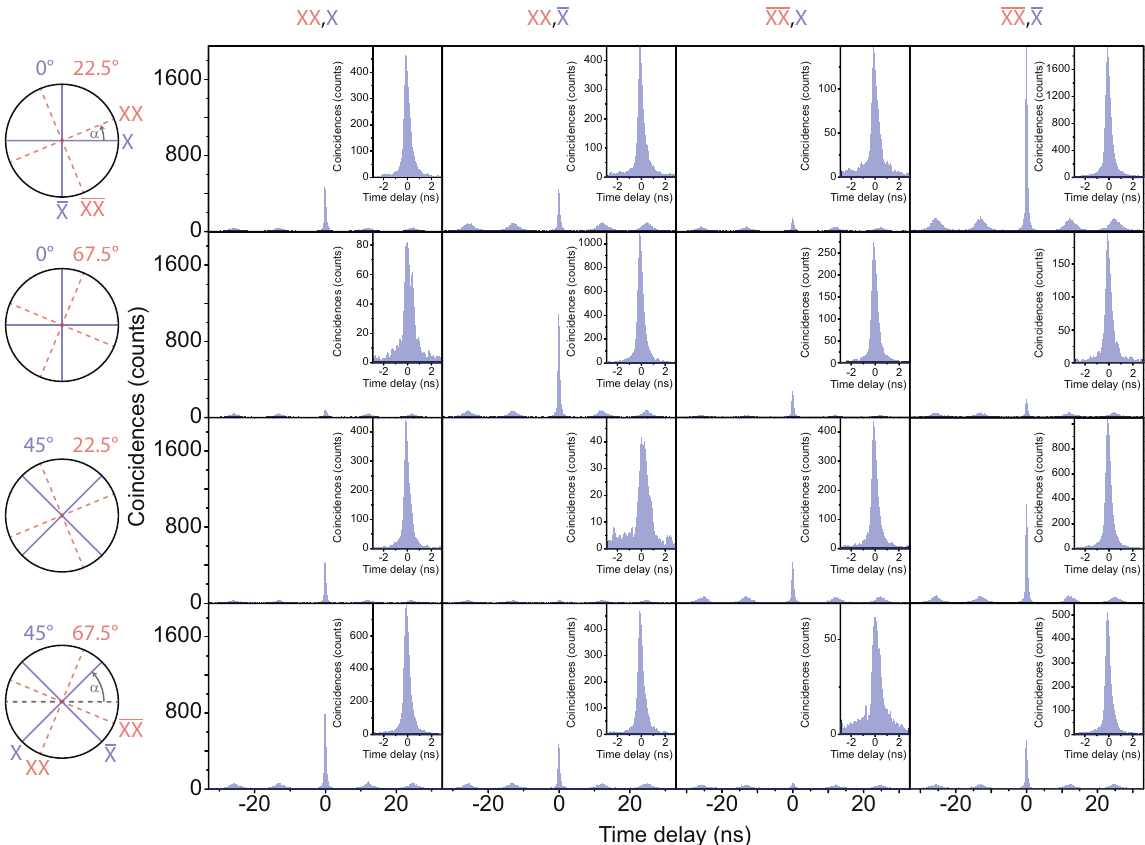
Figure 3. The sixteen cross-correlation measurements needed for the violation of the Clauser-Horne-Shimony- Holt inequality. The angles on the left specify how much the polarization detection angle α for the exciton (blue) and biexciton (red) is rotated with respect to the rectilinear basis in the laboratory reference frame. For each set of rotation the degree of correlation C b is extracted by measuring all four combinations between the biexciton (XX and XX ) and exciton (X and X ) photons. The insets show a magnification of the zero time delay peak.